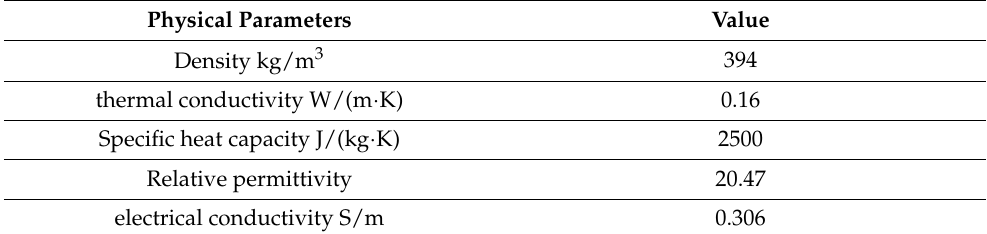
Table 4. Physical parameters of lung tissue in inflated